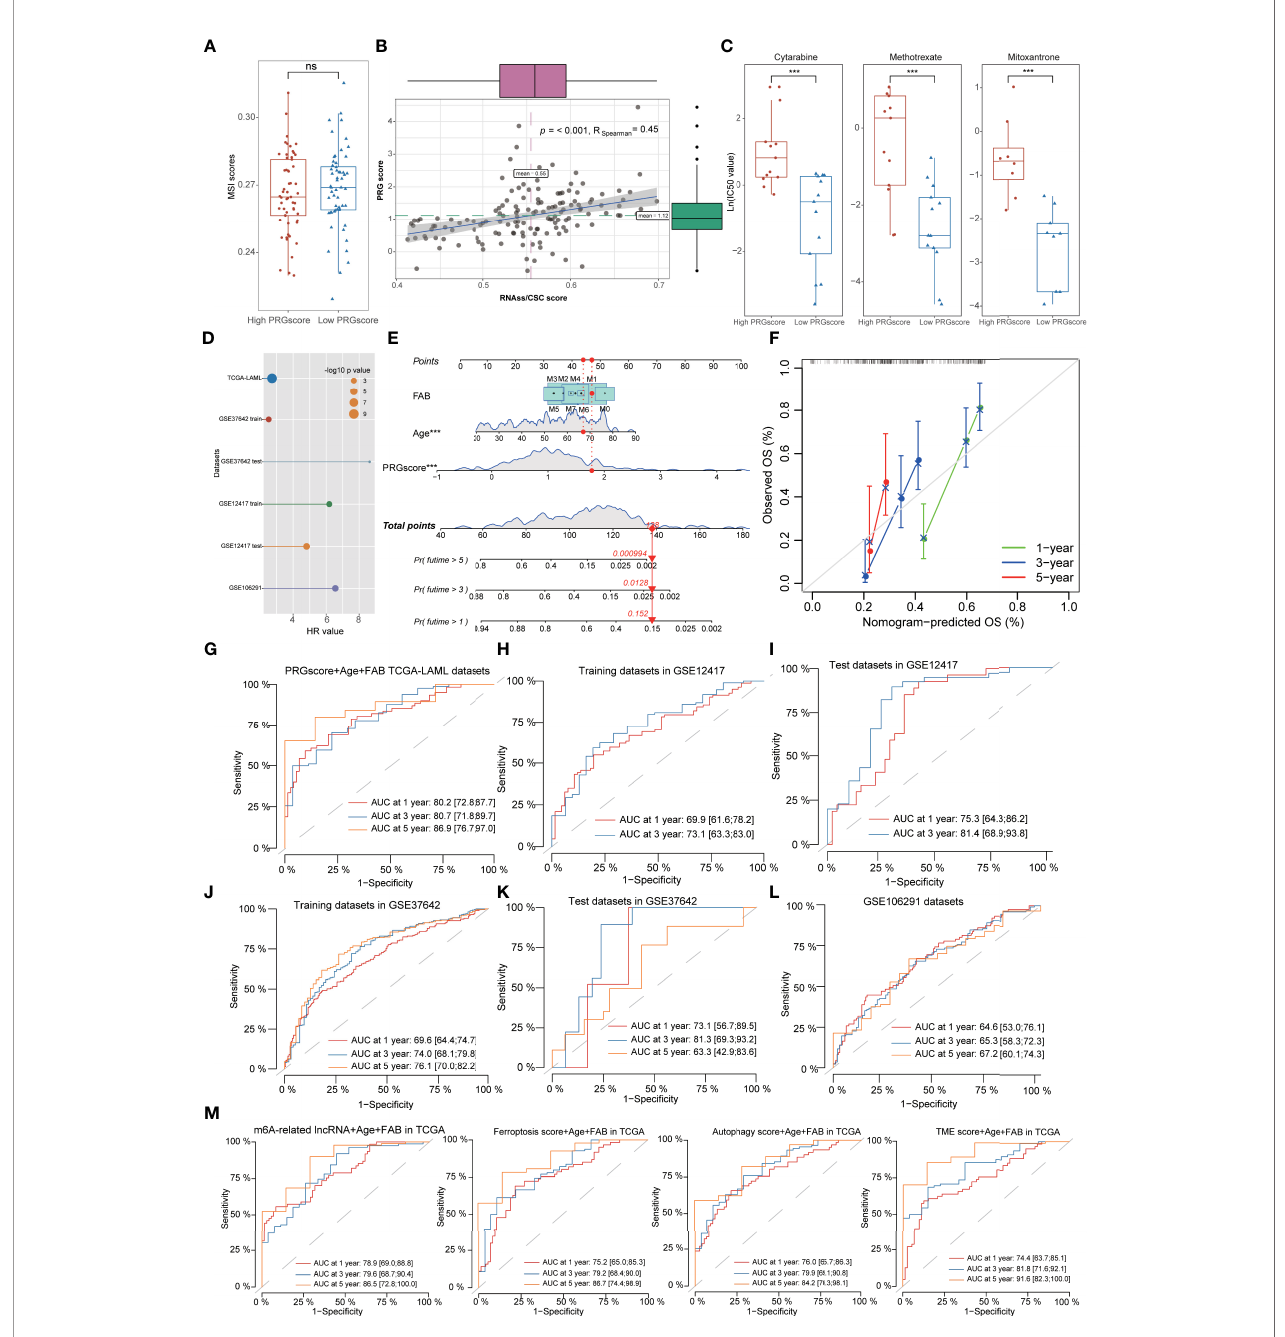
FIGURE 7 | Evaluation of therapeutic susceptibility and development of a prognostic model for AML. (A) There was no difference of MSI scores between high- and low-PRG score patients. (B) The correlation analyses revealed that PRG scores were signi fi cantly positively associated with mRNAsi. (C) The anti-AML chemotherapeutic drugs (cytarabine, methotrexate, and mitoxantrone) exhibited lower IC50 values in low-PRG score groups. (D) Univariate Cox regression analysis demonstrated that PRG scores could serve as an independent risk factor for the prognosis of AML with high HR values in multiple datasets. (E) A combined nomogram for predicting the probability of 1-/3-/5-year survival for AML patients. (F) The calibration curve of the established nomogram with 1-/3-/5-year survival, respectively. (G – L) Time-dependent receiver operating characteristic (ROC) curves of 1-/3-/5-year survival for AML patients in TCGA, GSE12417 training sets, GSE12417 test sets, GSE37642 training sets, GSE37642 test sets, and GSE106291 datasets. (M) Time-dependent ROC analysis of 1-/3-/5-year survival for AML patients using the gene models with existing signatures, including m6A-related lncRNA models, ferroptosis-related models, autophagy-related models, and TME score models. *P<0.05, **P<0.01, ***P<0.001; ns, not signi fi